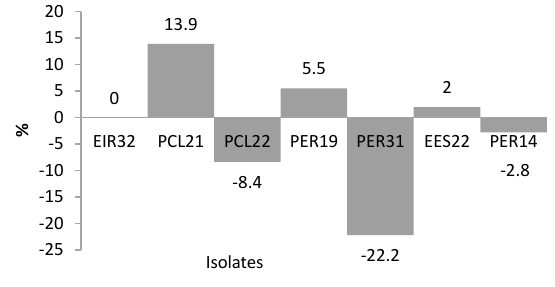
Fig. 4 Difference in the plant disease index (%) in the patho- gen-infected seedlings and the mycorrhized and pathogen- infected